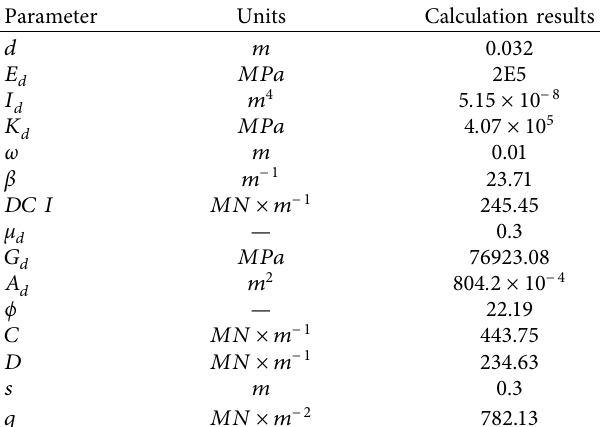
Table 2: Calculation process of joint stiffness. Parameter